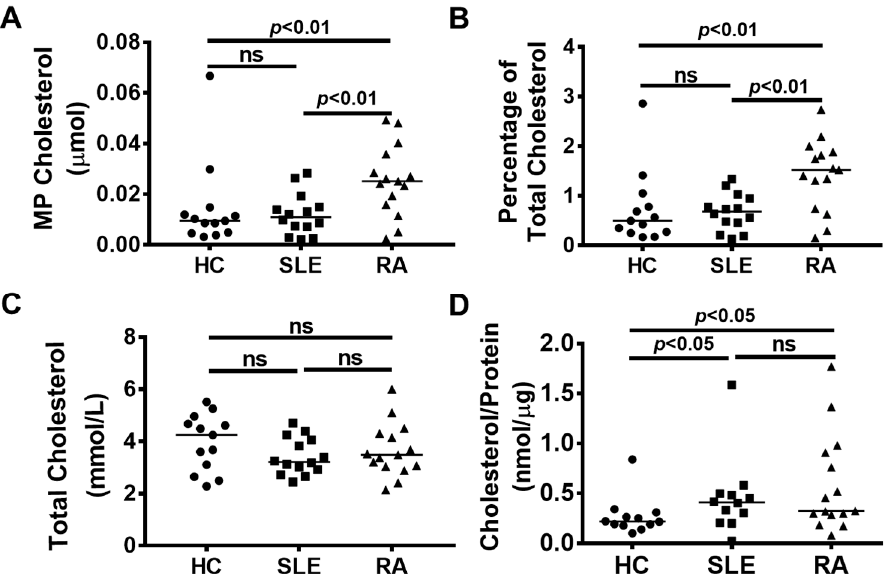
Figure 3. Rheumatoid Arthritis (RA) microparticles (MP) contain significantly more cholesterol than healthy control (HC) and systemic lupus erythematosus (SLE) MP. ( A ) Fractions 8 to 13 were pooled and the cholesterol content of MP was determined. RA MP contained significantly more cholesterol than both HC and SLE MP. ( B ) MP cholesterol was expressed as a percentage of the total plasma cholesterol in the HC and patient group. This proportion of cholesterol was significantly increased in RA patients compared to both HC and SLE patients. ( C ) There was no significant difference in the total cholesterol concentration between any group, with all participants having a total cholesterol measurement within the normal range. ( D ) The MP cholesterol to MP protein ratio was determined for all groups. The horizontal bar indicates the median; a p value <0.05 was considered significant. ns = not significant.